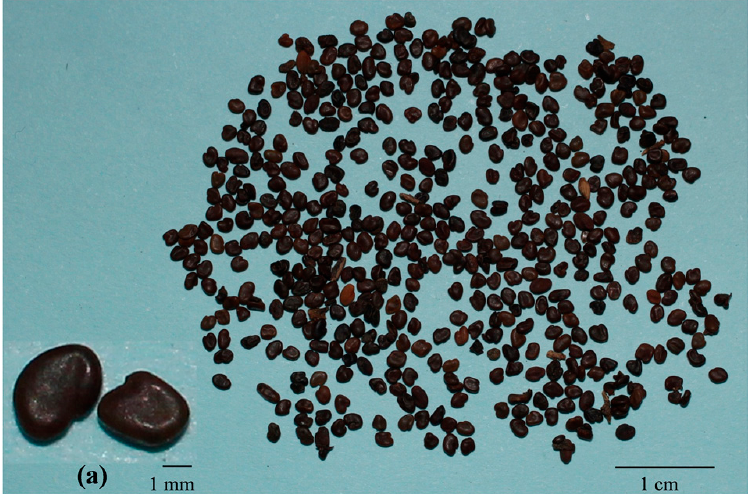
Figure 1. A photograph of Astragali Complanati Semen (ACS): ( a ) magnified ACS.